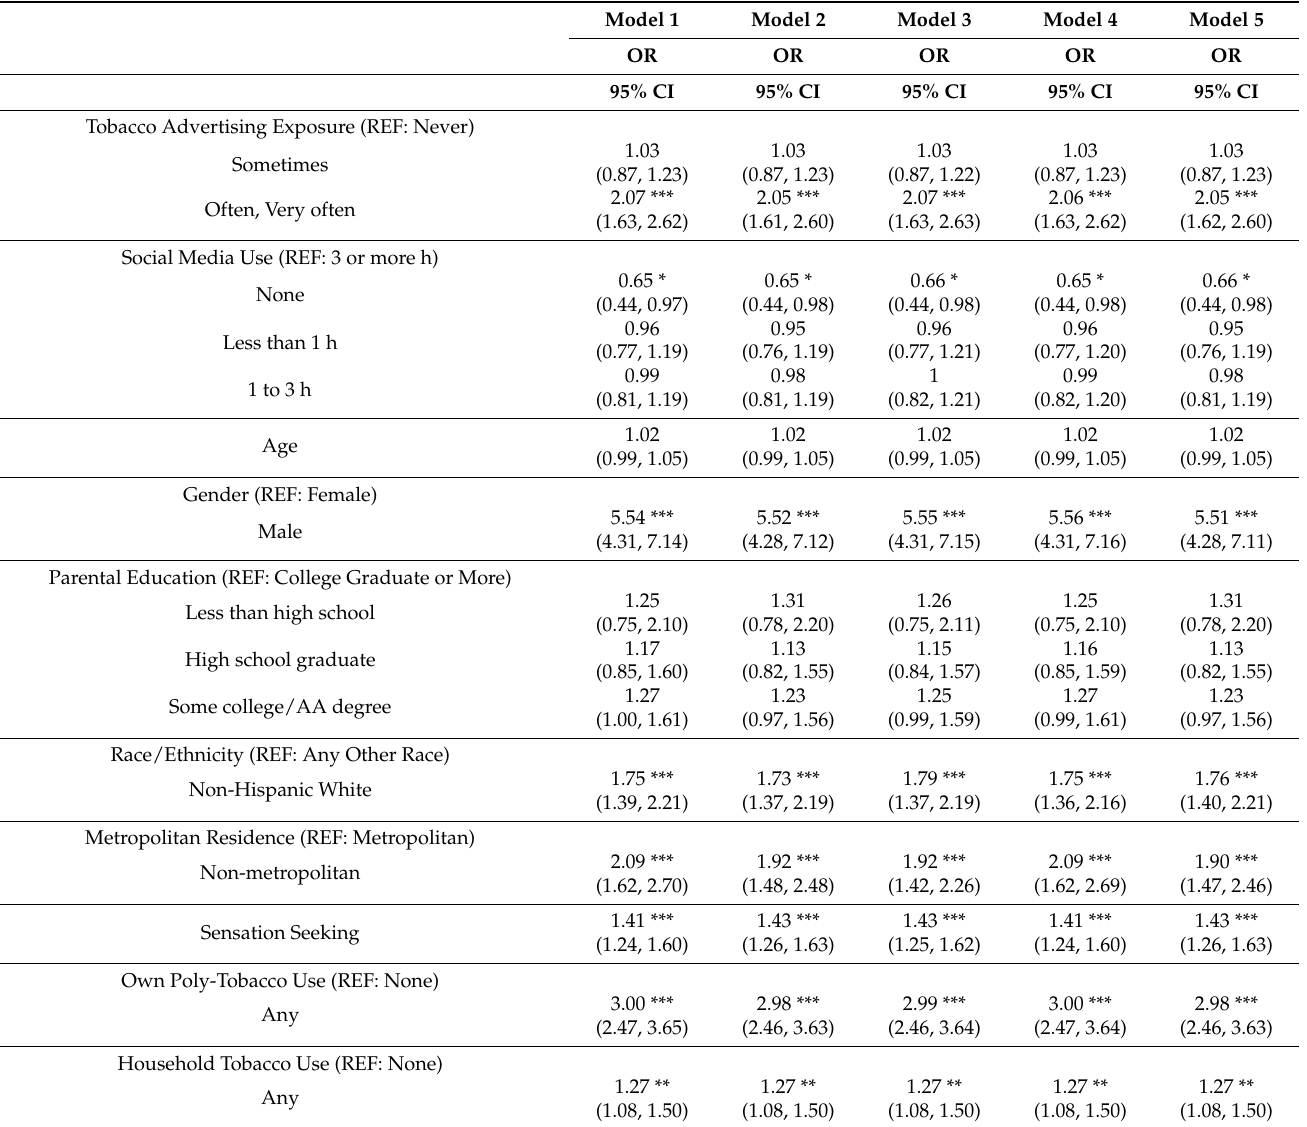
Table 3. Current smokeless tobacco use modeled against tobacco advertising expenditure, social media use, sociodemographic characteristics and policy variables using Waves 7,8 and 9 (2017–2019) of the national Truth Longitudinal Cohort